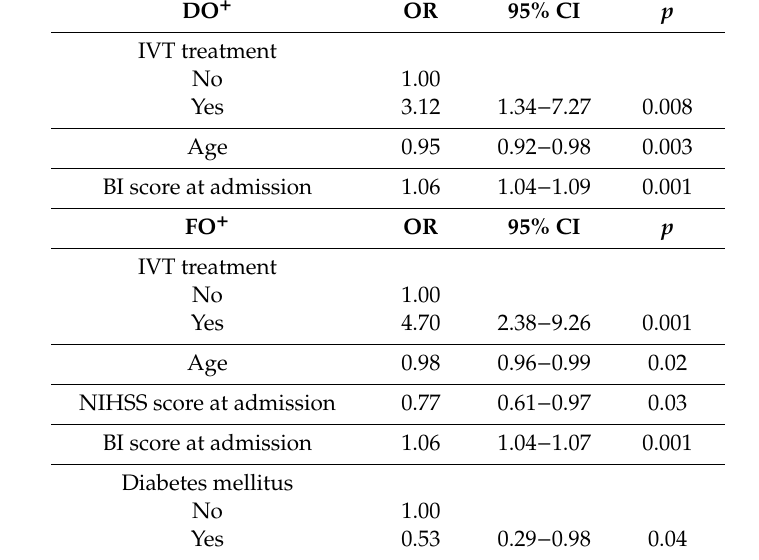
Table 3. Multivariable analyses showing independent predictors of positive disability outcome and positive functional outcome. DO + OR 95% CI p IVT treatment No 1.00 Yes 3.12 1.34 − 7.27 0.008 Age 0.95 0.92 − 0.98 0.003 BI score at admission 1.06 1.04 − 1.09 0.001 FO + OR 95% CI p IVT treatment No 1.00 Yes 4.70 2.38 − 9.26 0.001 Age 0.98 0.96 − 0.99 0.02 NIHSS score at admission 0.77 0.61 − 0.97 0.03 BI score at admission 1.06 1.04 − 1.07 0.001 Diabetes mellitus No 1.00 Yes 0.53 0.29 − 0.98 0.04 DO + (3-month mRS score of 0 or 1) = positive disability outcome; FO + (mRS score of 0 or 1 plus BI score of 95 or 100 at 3-months) = positive functional outcome; IVT = intravenous thrombolysis; NIHSS = National Institute of